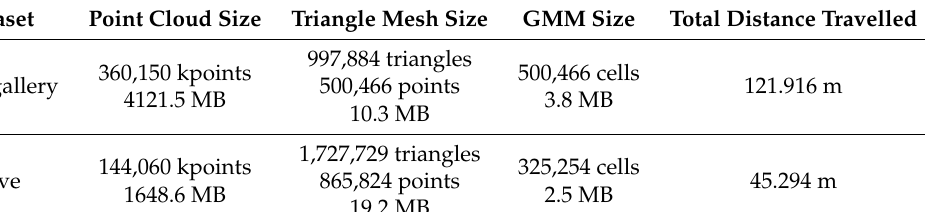
Table 1. Test datasets parameters.